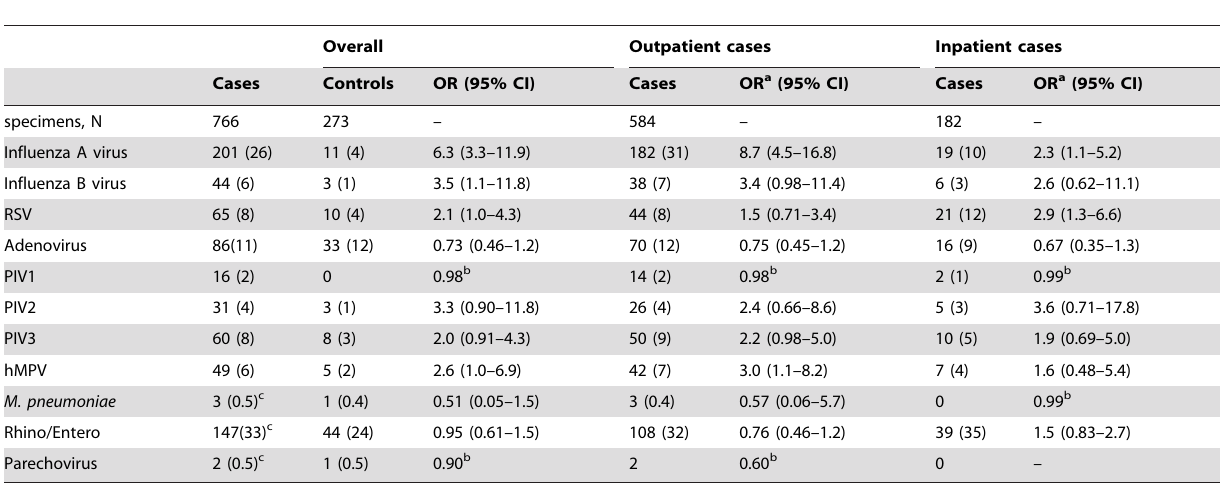
Table 4. Comparison of results of naso/oropharyngeal specimens between ARI cases and